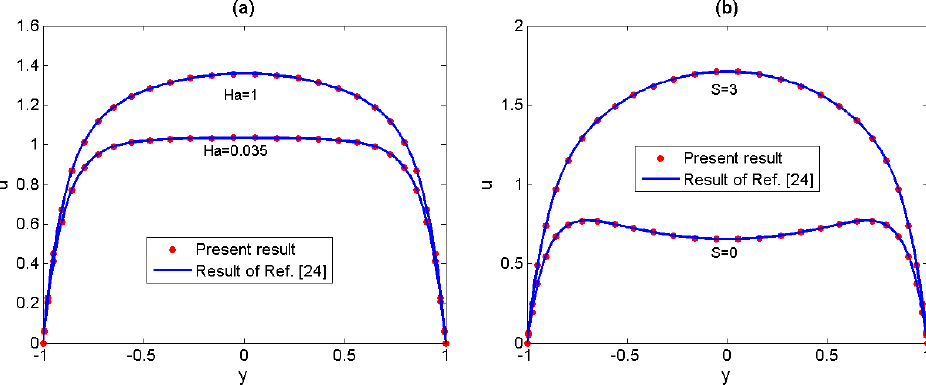
Figure 2. Comparisons of numerical velocity in our analysis with the analytical solutions of Chakraborty [24] for Newtonian fluid. ( a ) Λ = 0, S = 2, Ω = 0, K = 10; ( b ) Λ = 0, Ha = 1, Ω = 0, K = 10.